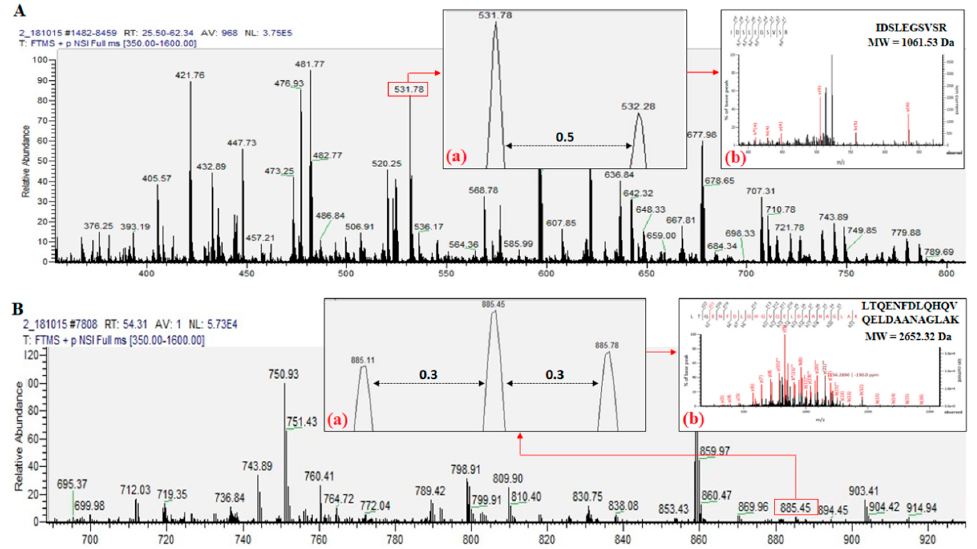
Figure 2. NanoLC-nanoESI-MS/MS spectra ( m / z region 350 to 800 Da and 690 to 930 Da) of oyster protein band B with representative spectra of identified tryptic peptides in doubly ( A ) and triply ( B ) charged signal. Out of 16,598,945 protein sequences discovered through Mascot database search, 352 proteins under the genus Crassostrea were identified. In each band, one protein (highest scoring Crassostrea sp.